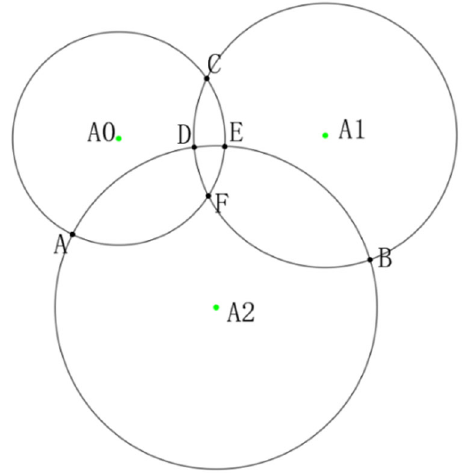
Figure 9. Schematic diagram of abnormal data position (The letters on the figure indicate the centers of the three circles or the points of intersection on the circles).